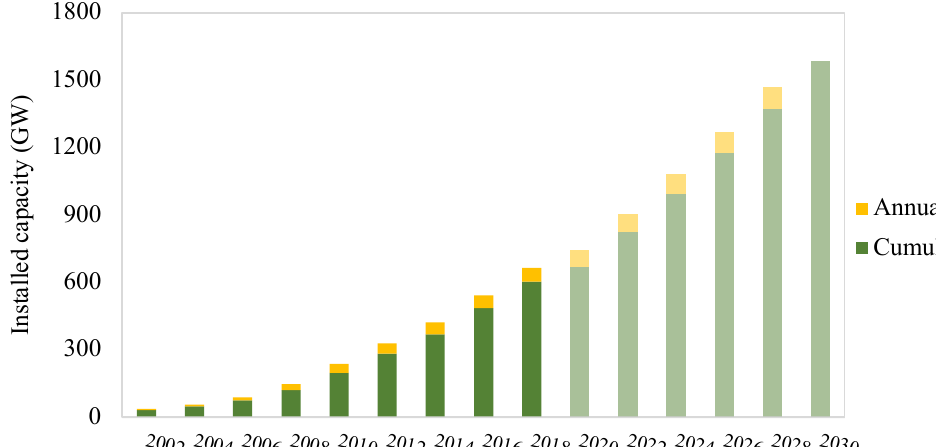
Figure 1. The projection of global cumulative and annual wind installed capacity by